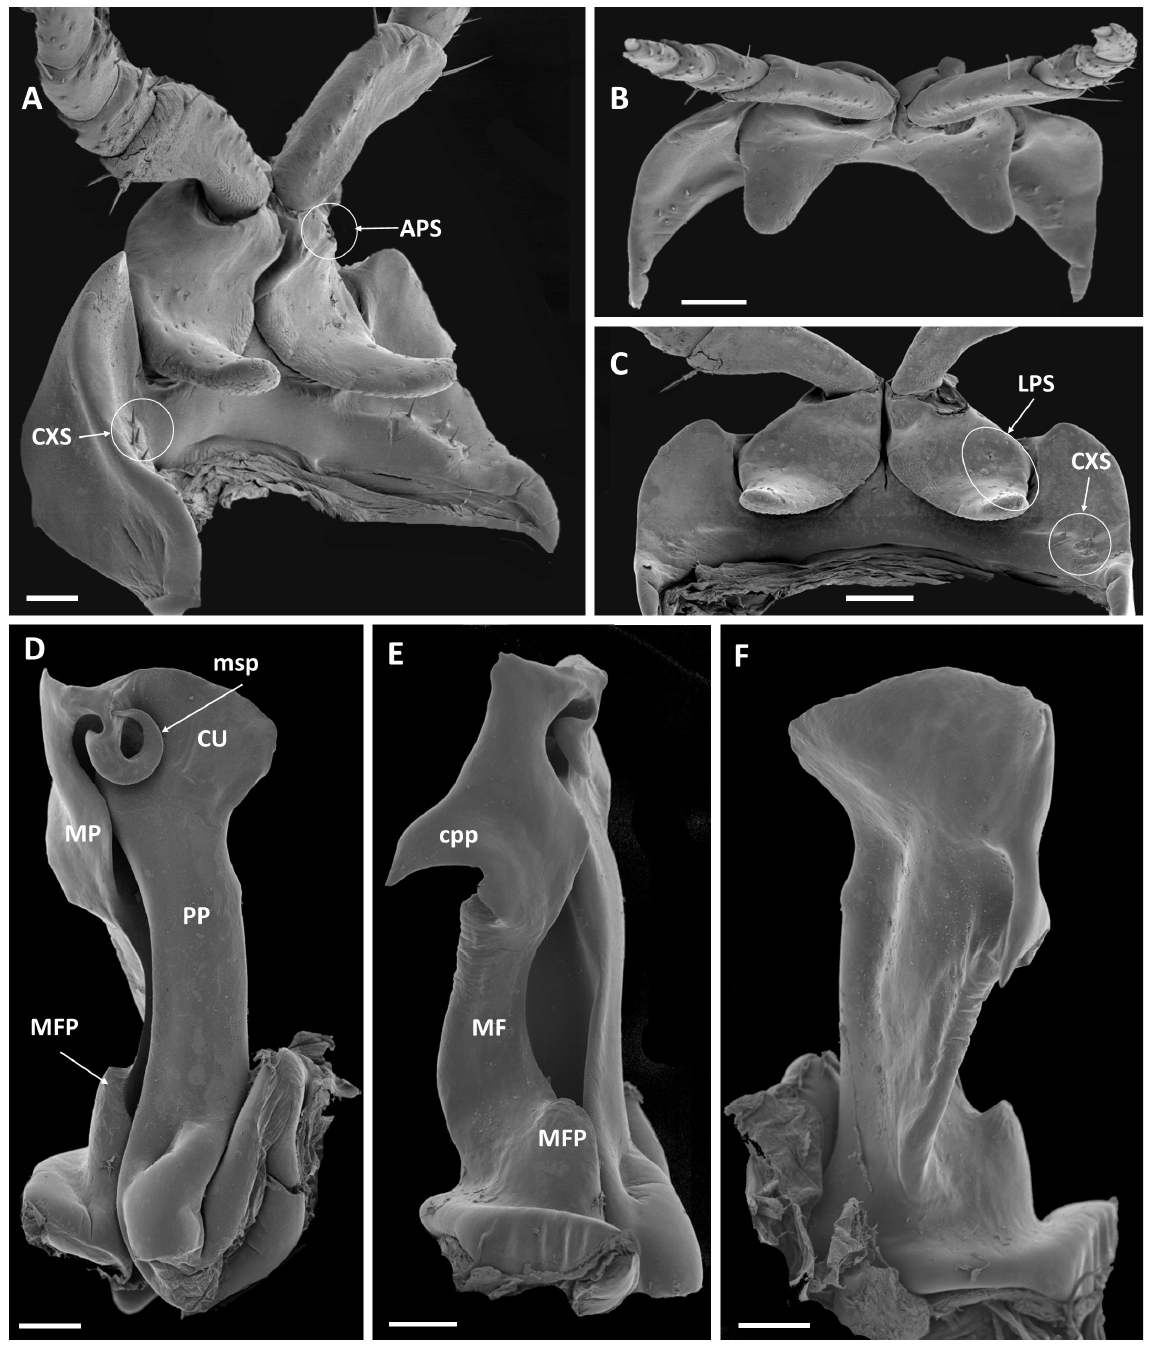
Fig. 24. Chaleponcus jolantae sp. nov., holotype, ♂ (NHMD 6217123). A–C . First pair of legs. A. Sublateral view. B. Ventral view. C. Anterior view. D–F . Right gonopod coxa. D. Anterior view. E. Mesal view. F. Posterior view. Abbreviations: APS = mesapical prefemoral setae; cpp = coxal posteriad process; CU = cucullus; CXS = coxosternal setae; LPS = lateral prefemoral setae; MF = metaplical flange; MFP = metaplical flange process; msp = metaplical spinelike process; PP = proplica. Scale bars: A = 0.1 mm; B–F = 0.2